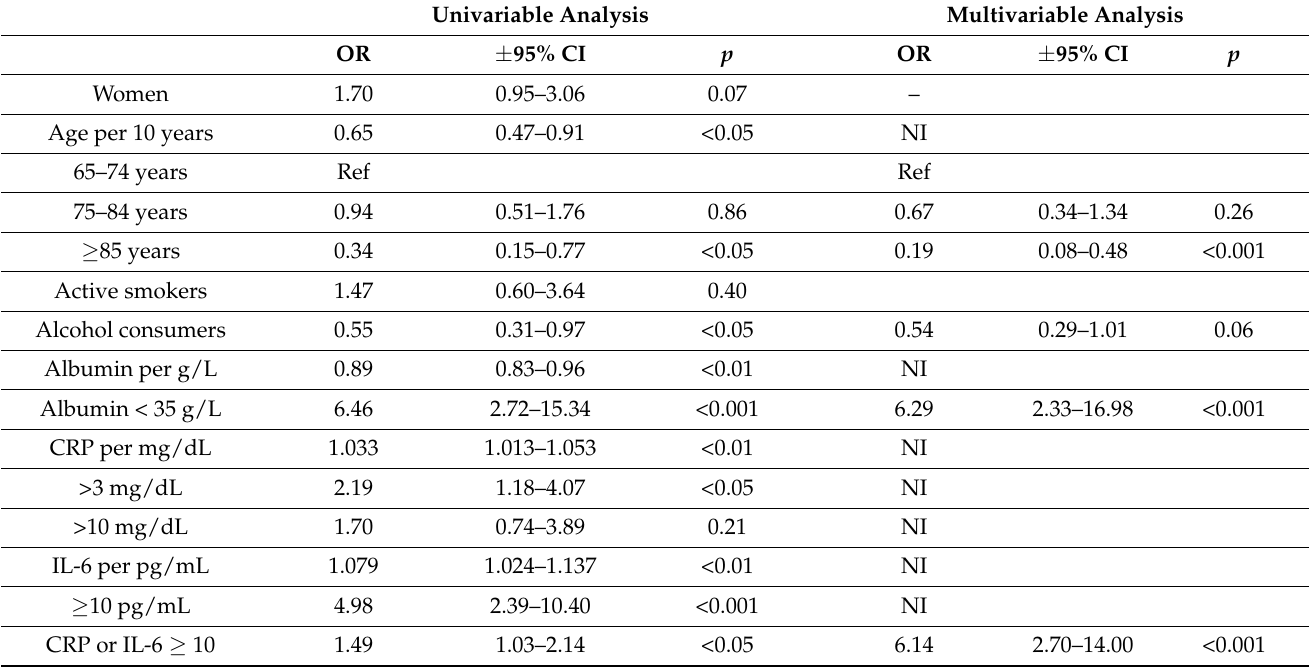
Table 2. Results of univariable and multivariable logistic regression analysis for anti-CCP positivity. Univariable Analysis Multivariable